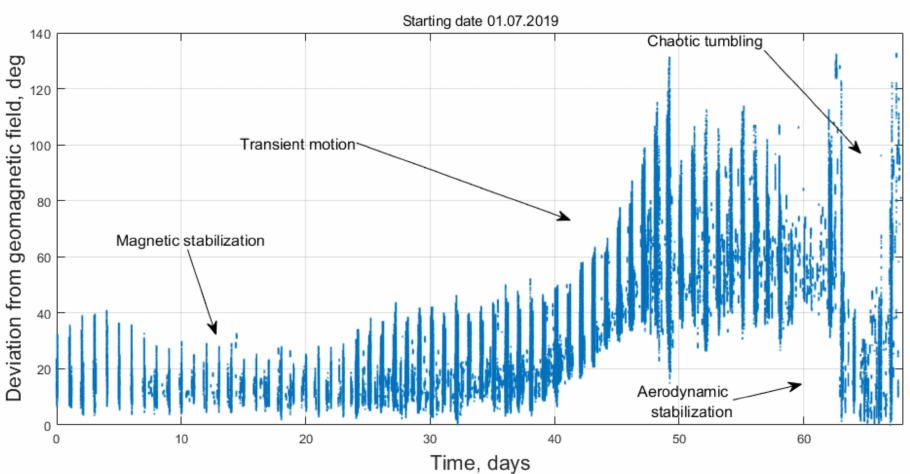
Figure 13. Deviation of OZ axis from the direction of the local magnetic field.